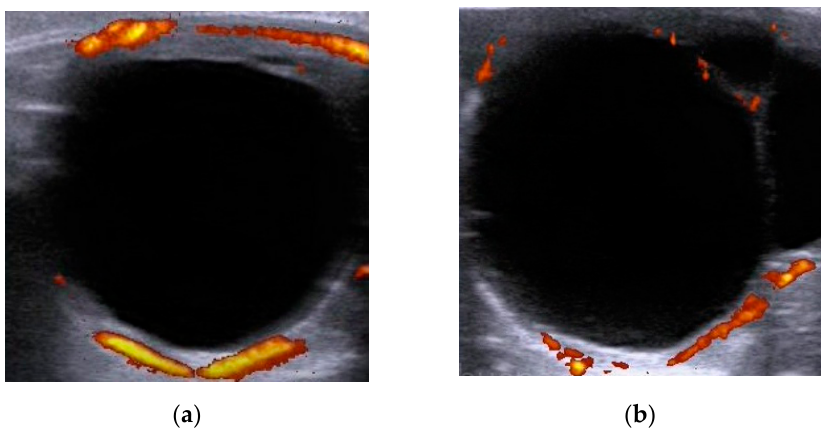
Figure 1. Representative image of preovulatory follicles, obtained at the time of ovulation induction, using Power Doppler ultrasound. ( a ) Blood flow follicle of a young mare; ( b ) Blood flow follicle of an aged mare.